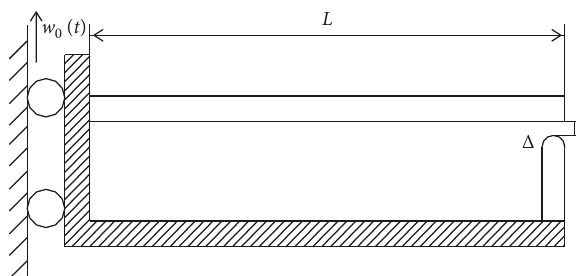
Figure 1: Cantilever vibro-impact